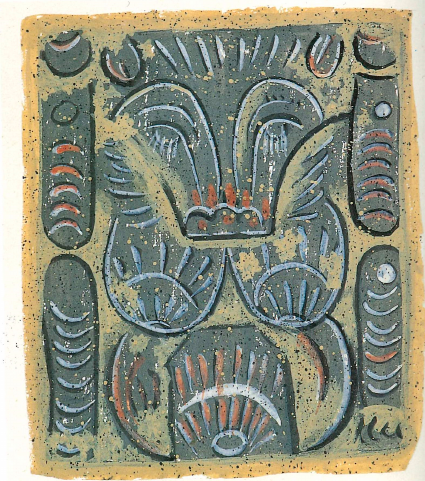
Figure 15. Bear, screen wall, Foyemiaowan M133, carved and painted brick, Western Jin period (265–317). (Gansusheng Wenwu Kaogu Yanjiusuo 1998, pl. 70.3). ©Wenwu Press. This figure published with permission of Wenwu Press and cannot be used or copied without their